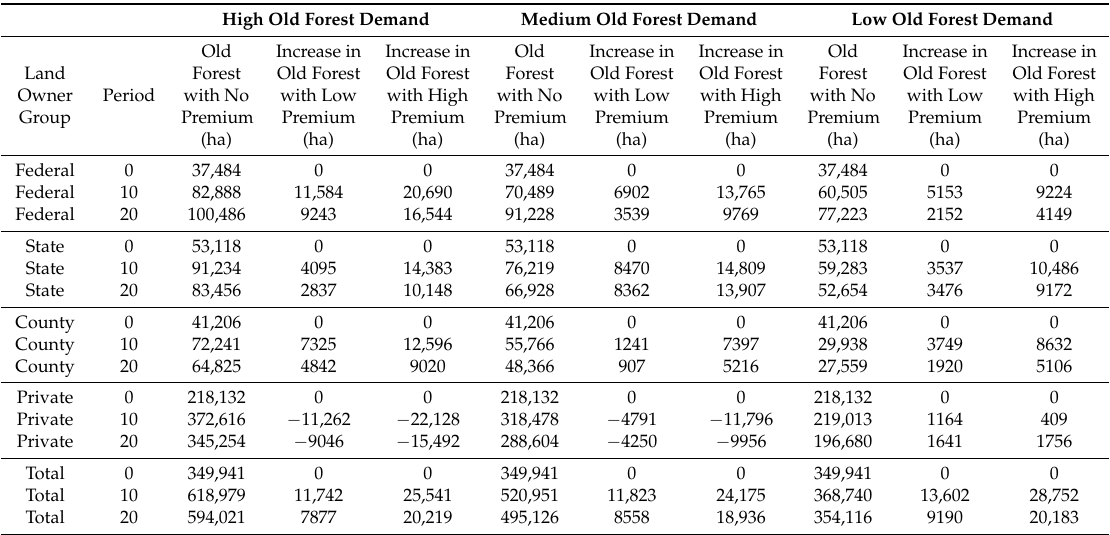
Table 3. Comparison of model results for nine scenarios in terms of the impact of premiums used for old forest based on ownership, forest cover type and stand